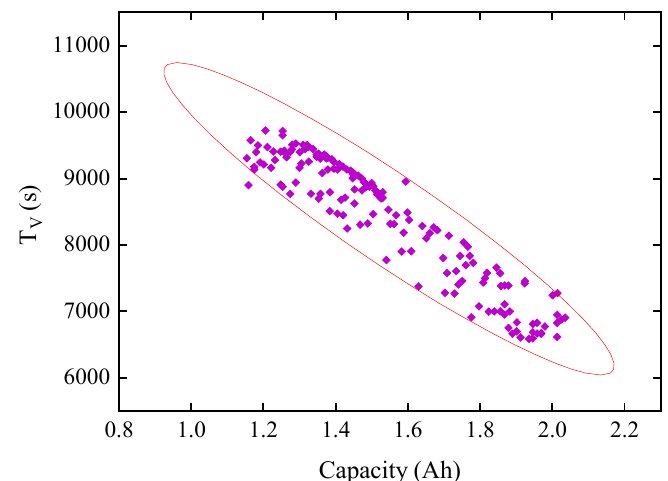
Figure 5. Scatter figure of T V .